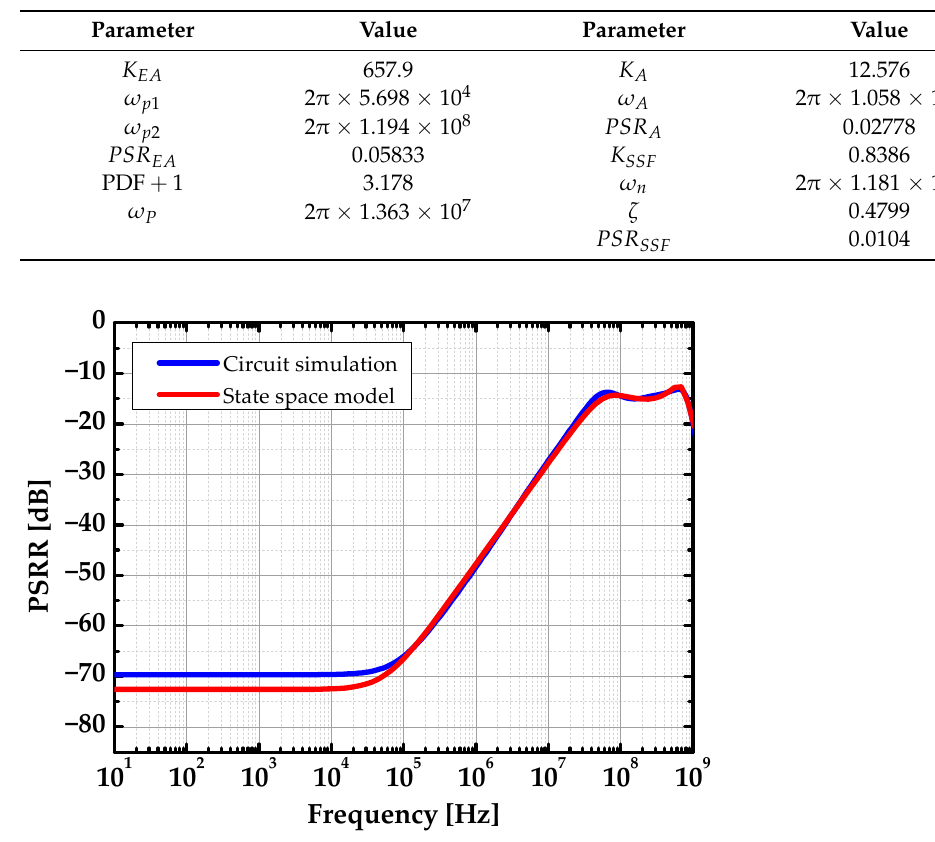
Table 2. Parameters used in the state space model.